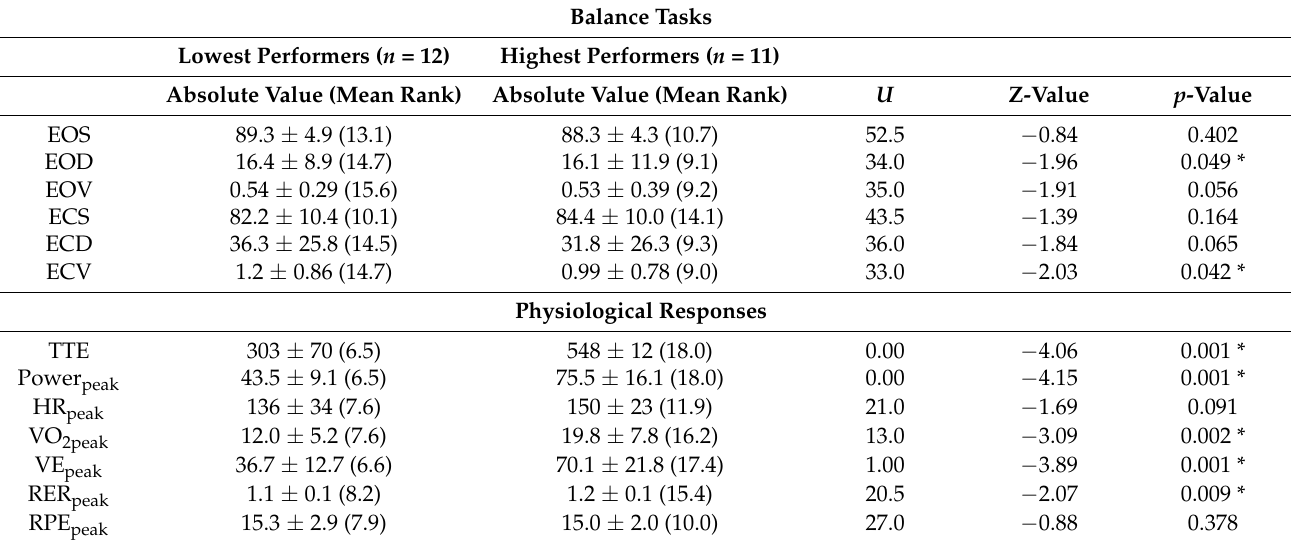
Figure 2. Correlation matrix for Spearman’s rho of balance task and arm crank exercise variables. The colors of the scale bar denote the direction of the correlation with 1 indicating a perfect positive correlation (dark red) and − 1 indicating a perfect negative correlation (dark blue) between balance and physiological variables. * correlation is significant at the (0.05) level (2-tailed). Table 3. Absolute values (mean ± sd) and mean ranks for balance and physiological variables between lowest and highest performers on arm crank exercise.